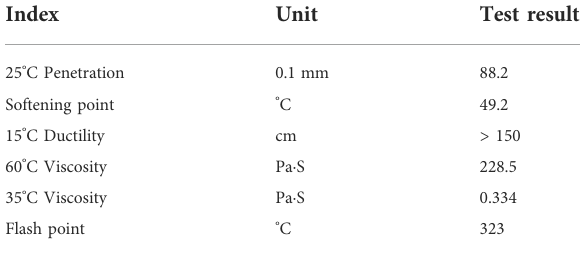
FIGURE 1 Fractional derivative Abel dashpot element.